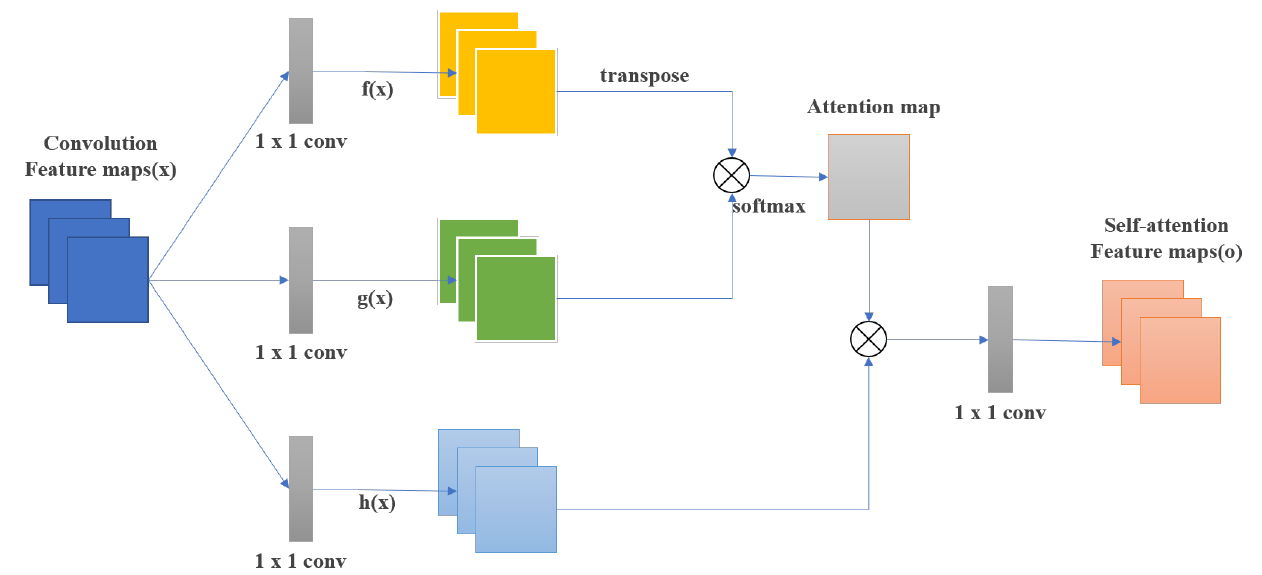
Figure 1. The self-attention module for SACVAEGAN. The ⊗ denotes matrix